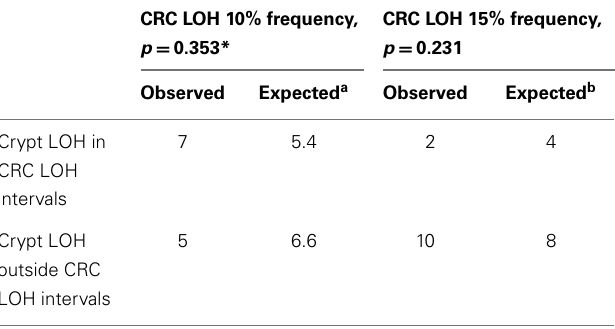
Table 3 | Crypt chromosome copy number alterations versus common colorectal chromosome copy number alterations.